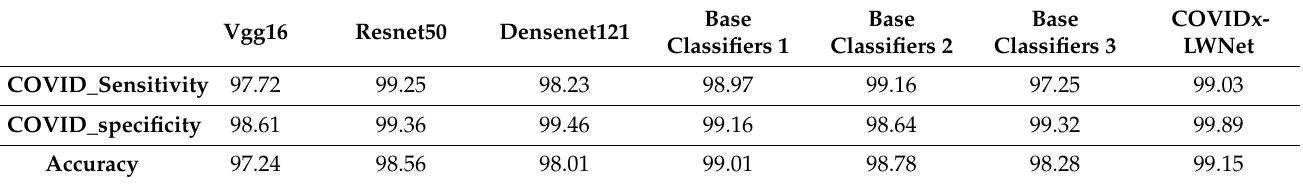
Table 9. D3_1:D3_1 (train: test), three-class.